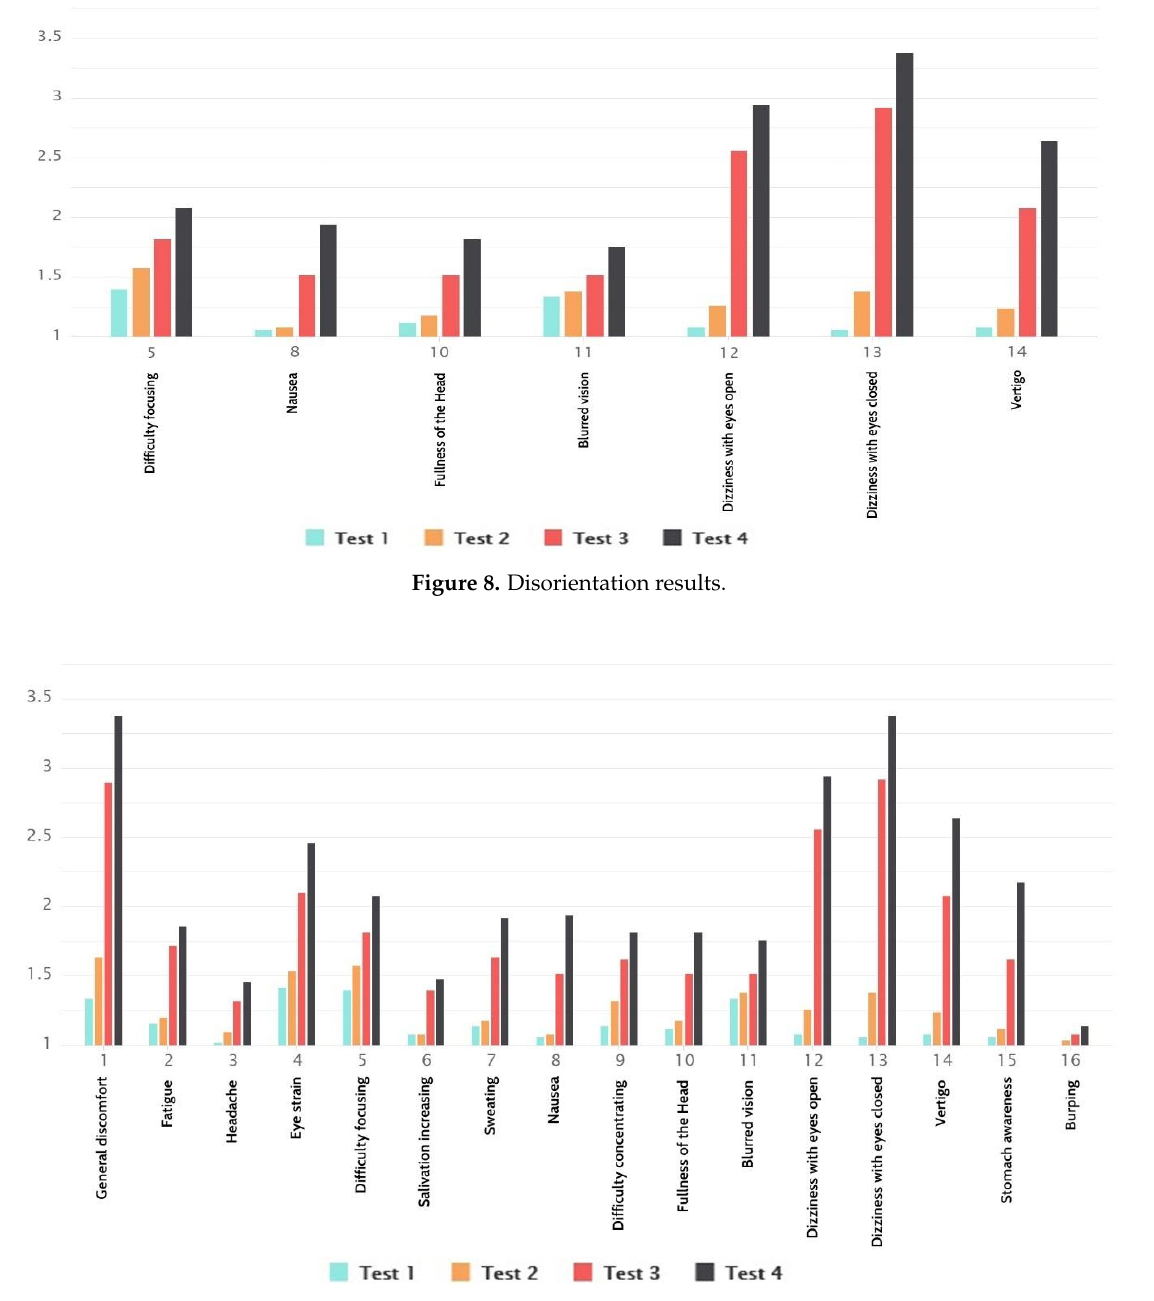
Figure 9. Total Simulator Sickness Questionnaire (SSQ) results.